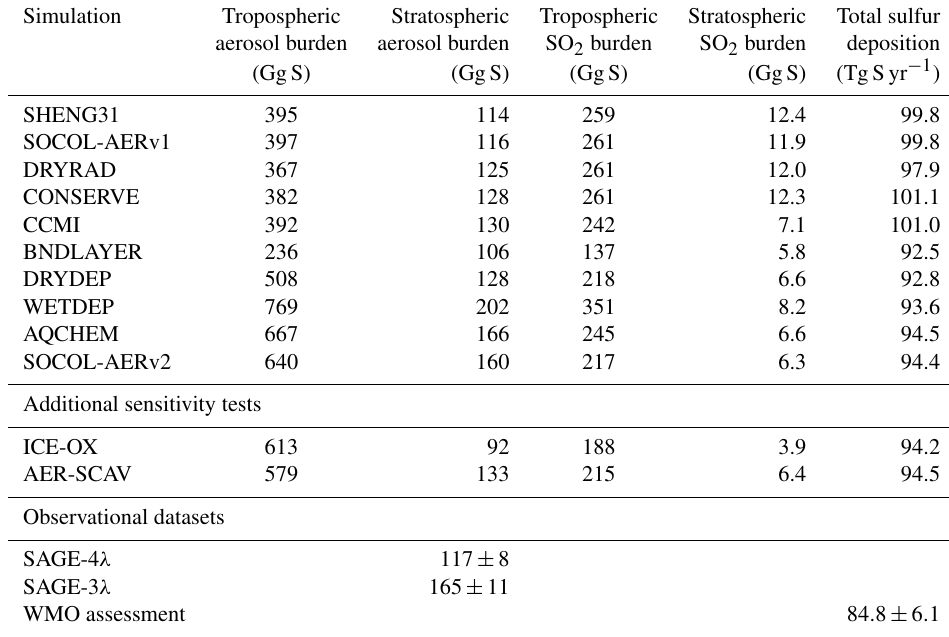
Table 2. Global annual mean sulfate aerosol and SO 2 burdens in the troposphere and stratosphere for all volcanically quiescent time-slice (year 2000) simulations in the development of SOCOL-AERv2. Total sulfur deposition (last column) is listed as a check of whether the mass balance of the model has changed. Model results are compared to two datasets, SAGE-3 λ and SAGE-4 λ , which derived stratospheric aerosol burdens from satellite extinction measurements. The model tropopause is used to separate tropospheric and stratospheric burdens, whereas for the SAGE-3 λ and SAGE-4 λ calculations the MERRA tropopause is used. The WMO assessment (Vet et al., 2014)